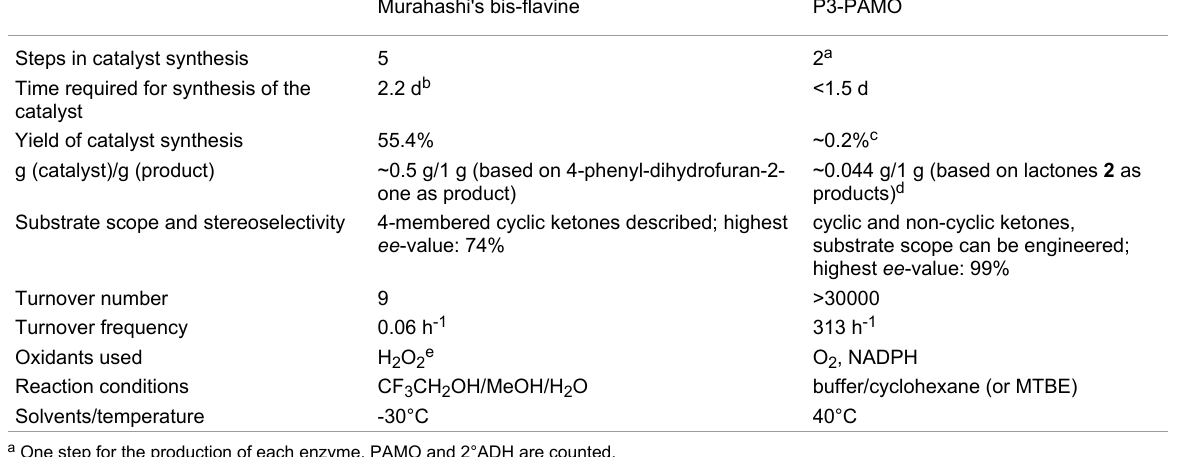
Table 3: Comparison of P3-PAMO with Murahashi's chiral bisflavin organocatalyst as a chemical model catalyst for enantioselective